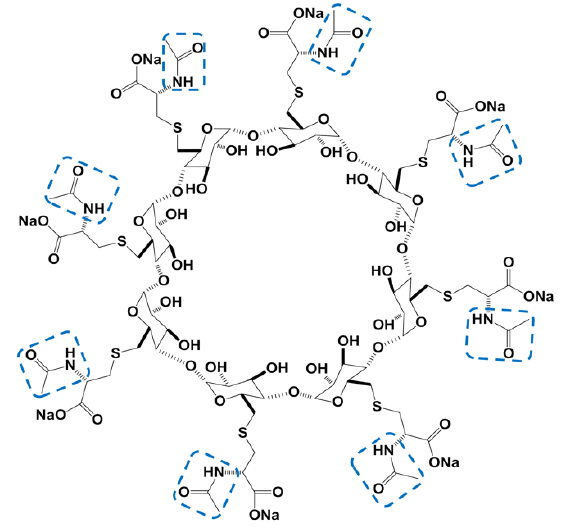
Figure 1. The chemical structure of adamgammadex.